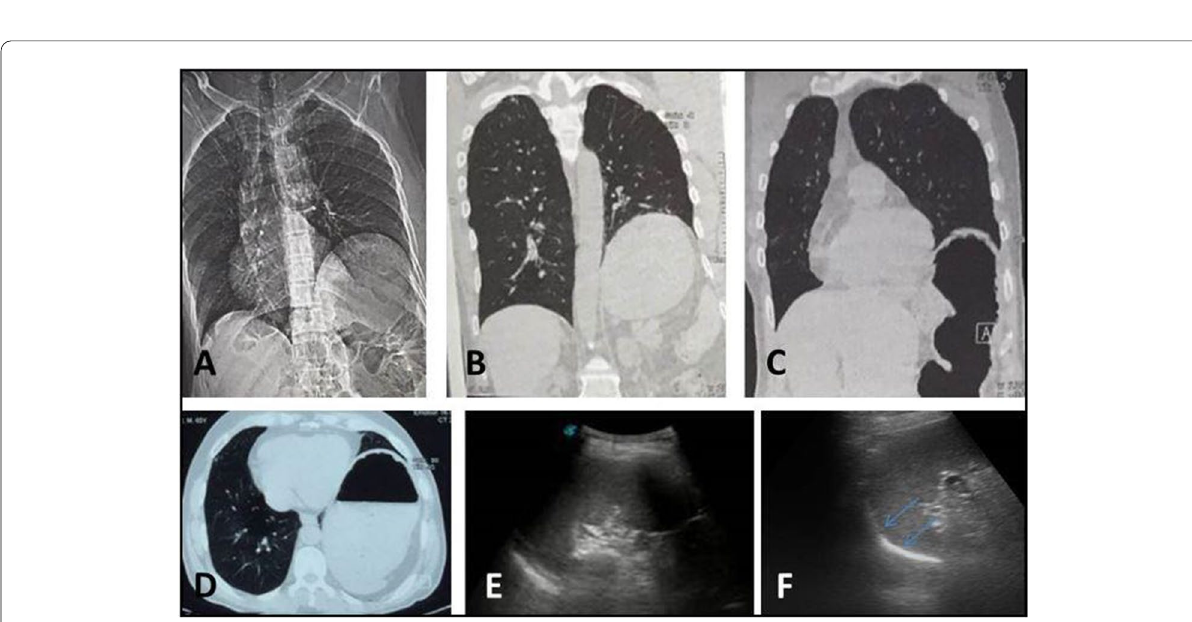
Fig. 2 Male patient 60 years old with left diaphragmatic paralysis: A Pre‑operative CXR showing significant left diaphragmatic paralysis. B – D CT images showing the gastric contents at the site of the paralysis. E , F Post‑operative DUS images showing the left diaphragm